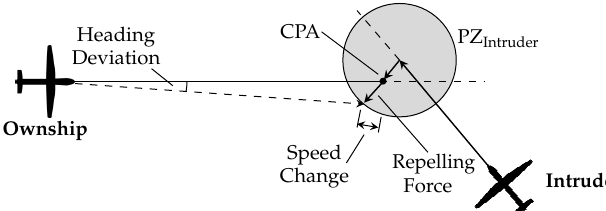
Figure 3. Modified Voltage Potential (MVP) geometric resolution. Adapted from